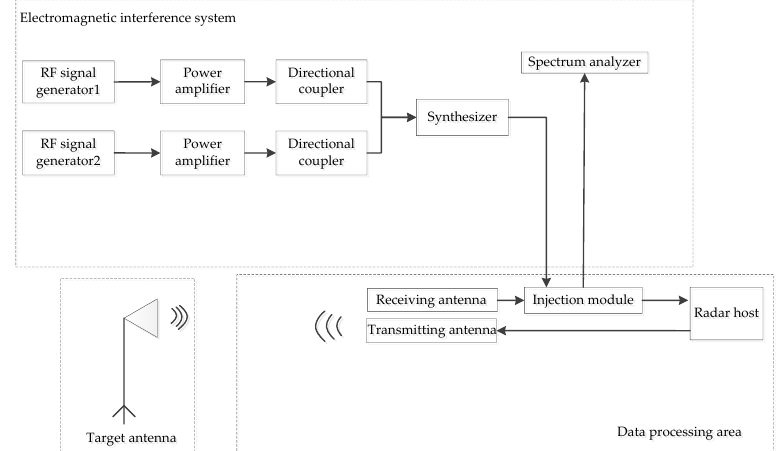
Figure 1. The flow chart of the test system.